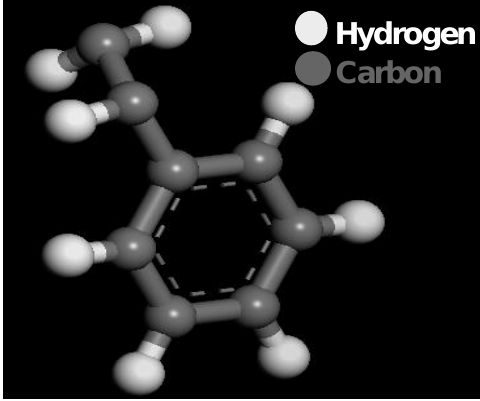
Figure 1. Molecular formulation of PS chains.